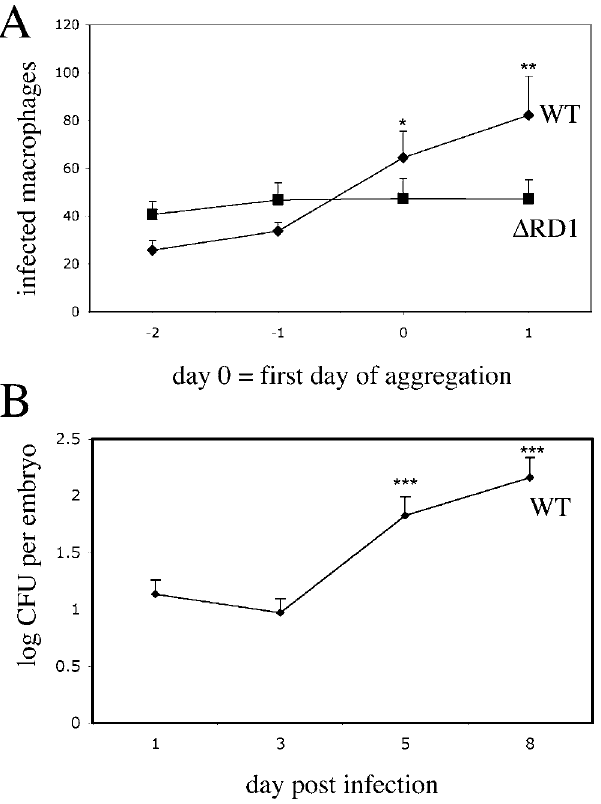
ination during WT Infection (A) Enumeration of infected macrophages in embryos by fluorescent and DIC microscopy after infection with green-fluorescent bacteria. Infecting doses: 151 CFU for WT, 301 CFU for D RD1. Time points are in reference to day of aggregate formation, which is set at 0. 15 WT infected embryos and 13 D RD1 embryos were monitored. The graph represents all 15 WT embryos, but only the 7/13 D RD1 infected embryos that formed aggregates over the course of the experiment. Error bars are 6 SEM. (* p = 0.0136 comparing WT day 0 and WT day –2; ** p = 0.0053 comparing WT day 1 and WT day –2, unpaired Student’s t -test). (B) Whole embryo bacterial counts following WT infection (*** p (cid:1) 0.0003, 5 d postinfection and 8 d postinfection, respectively, compared to 3 d postinfection, unpaired Student’s t -test). DOI: